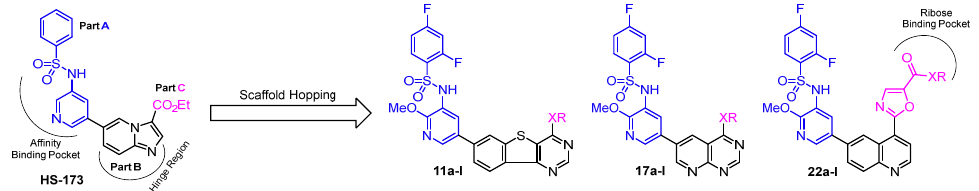
Figure 2. Design strategy of sulfonamide methoxypyridine derivatives as PI3K/mTOR dual inhibi- tors.